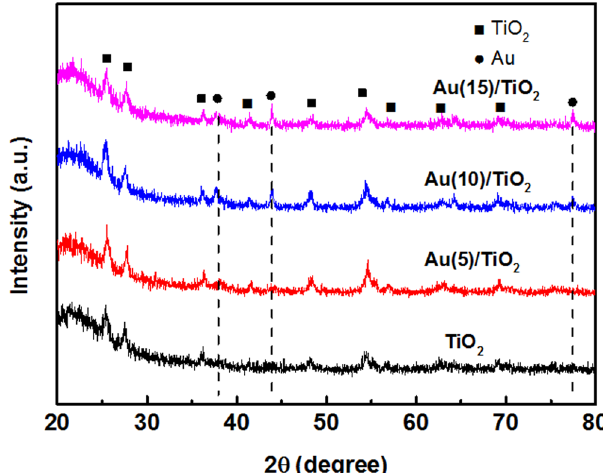
Figure 1. XRD patterns of the pure TiO 2 nanofibers and Au/TiO 2 nanofibers Au(5)/TiO 2 , Au(10)/TiO 2 and Au(15)/TiO